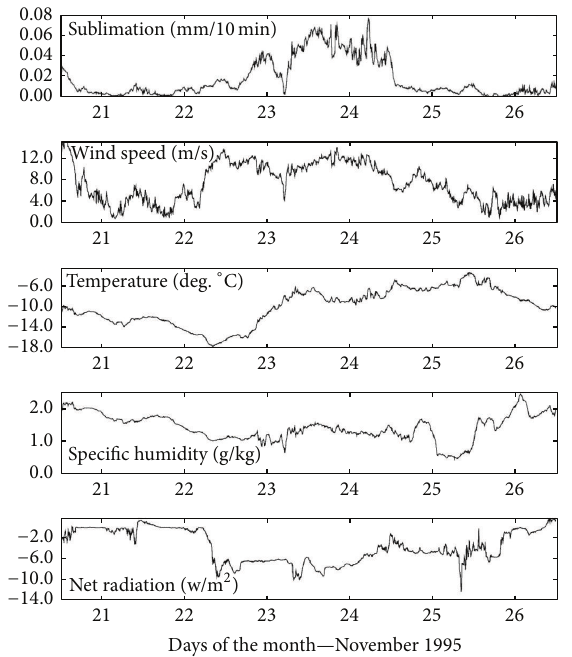
Figure 3: Reproduced from Hood et al. [14] as in Figure 2 but for seven days in February. Condensation is represented by negative values in the top